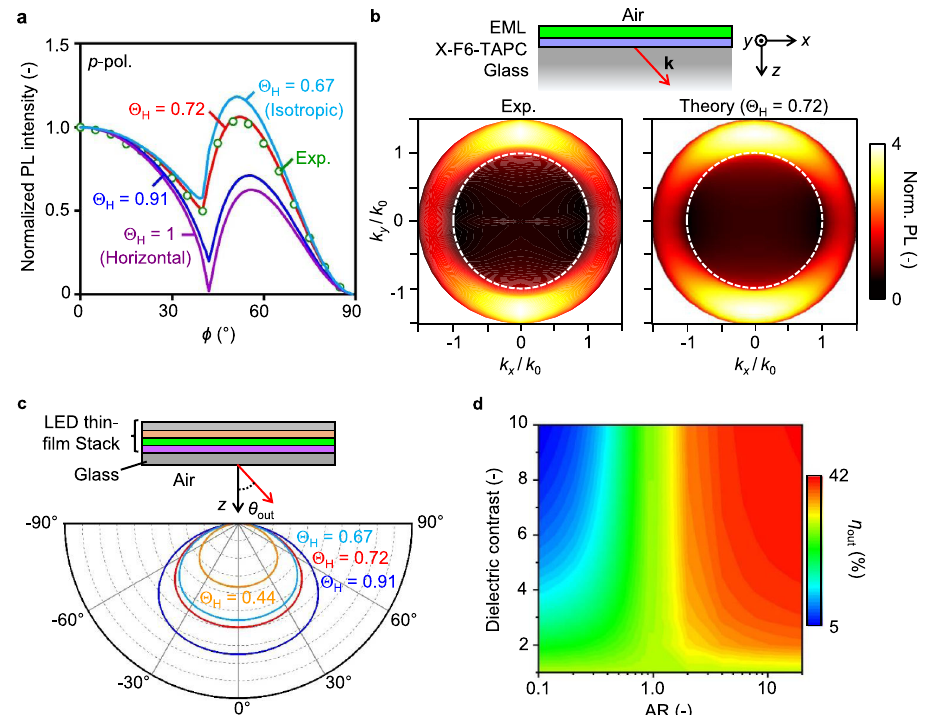
Fig. 3 Analysis of EML radiation patterns and outcoupling ef fi ciency calculations. a Experimentally characterized (Exp.) and optical theory-calculated thin- fi lm p -pol PL intensity as a function of viewing angle ϕ , using the thin- fi lm horizontal dipole ratio Θ H as the control parameter. b Experimentally characterized (left) and theory- fi tted (right; Θ H = 0.72) thin- fi lm k -space radiation patterns considering the dielectric stack of EML/X-F6-TAPC/Glass. c Calculated far- fi eld emission patterns (FEPs) generated by EMLs in our optimized LED stack for Θ H values of 0.44, 0.67, 0.72, and 0.91, revealing a stronger radiation power outcoupled to air by increasing EML Θ H . d Calculated light outcoupling ef fi ciency η out as functions of the NC aspect ratio AR and dielectric contrast e ϵ , under the assumption of thin- fi lm Θ H equal to Θ IP in individual